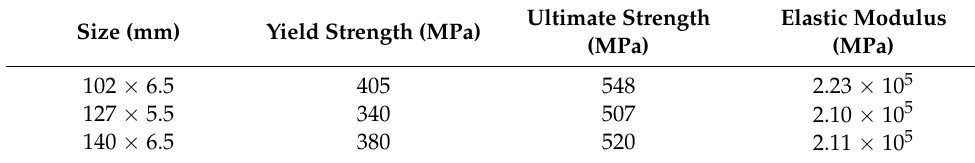
Table 10. Material properties of steel